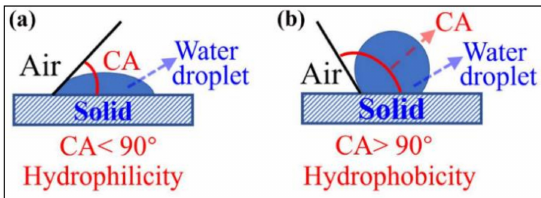
Figure 1. Illustration of the surface wettability of a solid. ( a ) Hydrophilicity and ( b ) hydrophobicity.